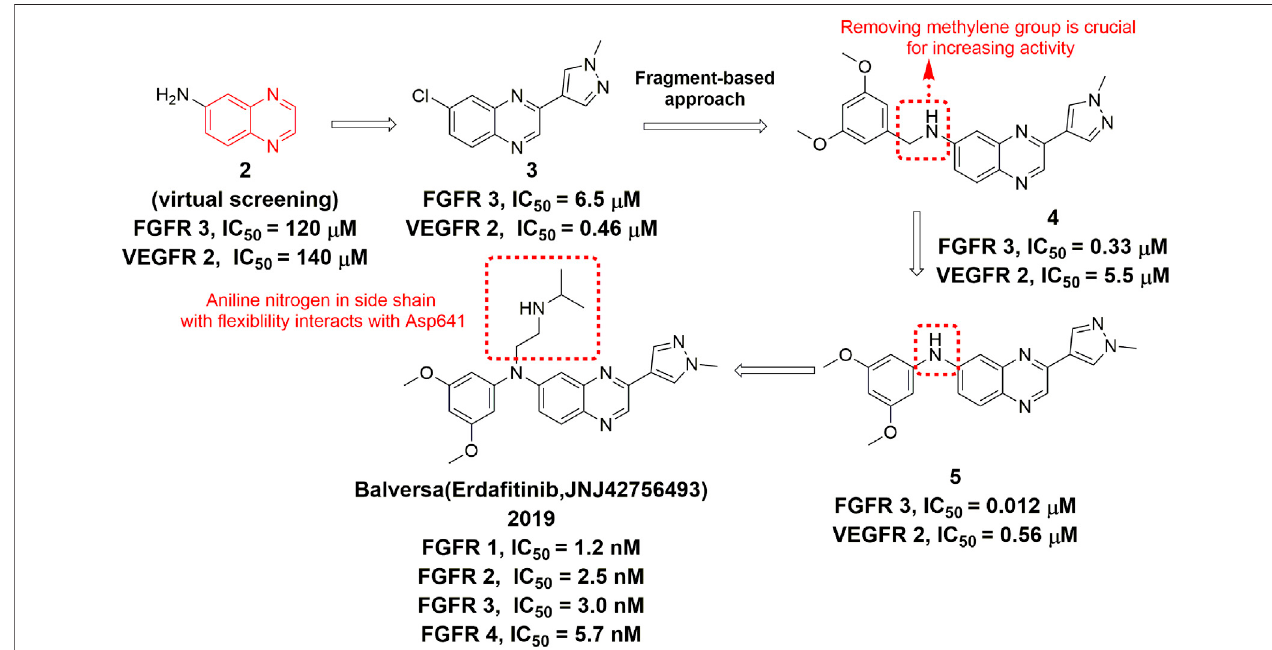
FIGURE 6 | Discovery of erda fi tinib.